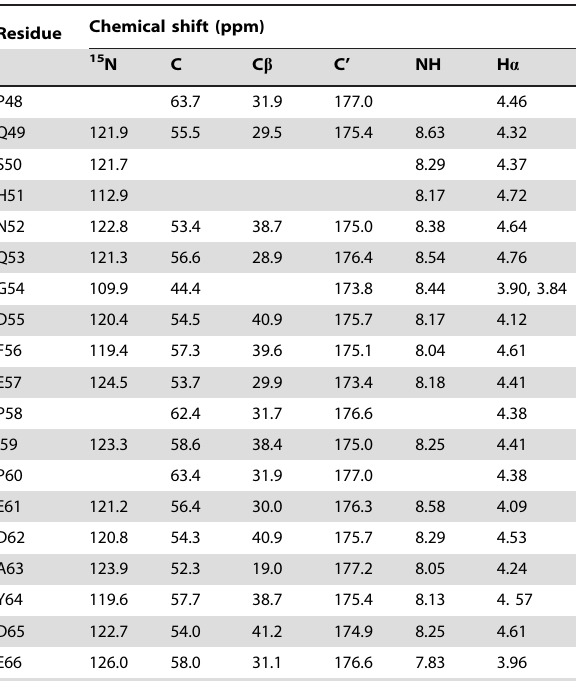
Table 3. 15 N, 13 C and 1 H Resonance Assignments for r-RGD- Hirudin at pH 7.4 and 25 u